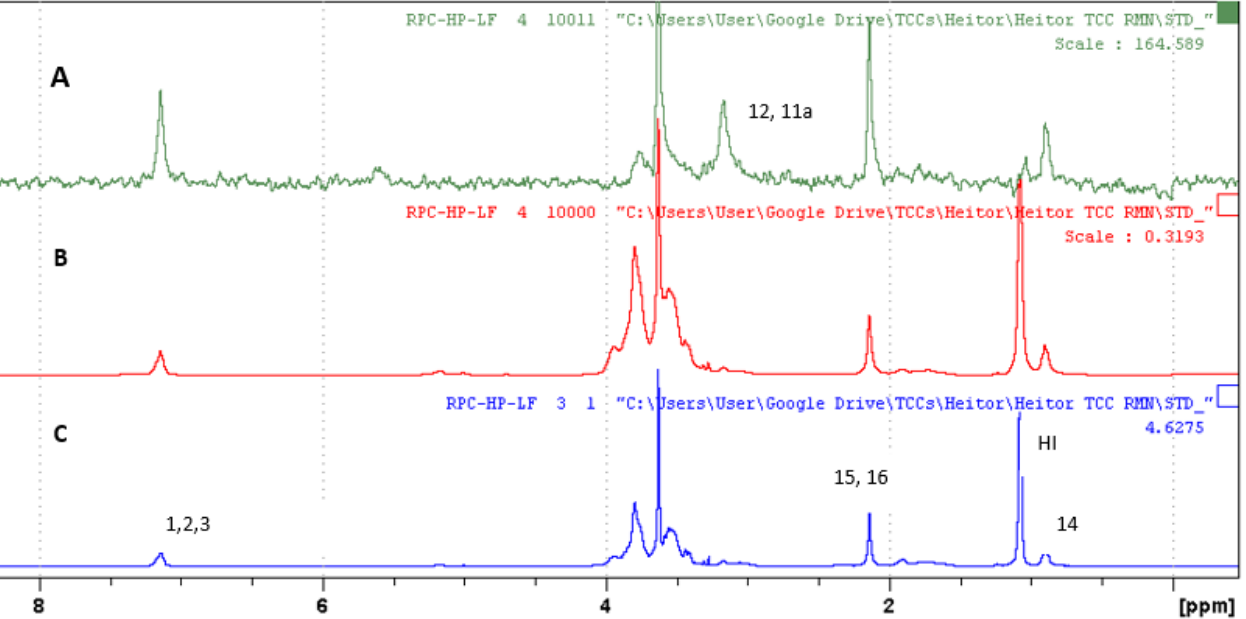
Figure 5. ( A ) STD spectrum (radiating at − 0.5 ppm); ( B ) control spectrum (radiating at 30 ppm); ( C ) 1 H NMR spectrum (400 MHz, D 2 O/residual H 2 O reference at 4.7 ppm) of RVC/HP- β CD/SL complex [50 mmol L − 1 ]. Total saturation time 2.55 s.